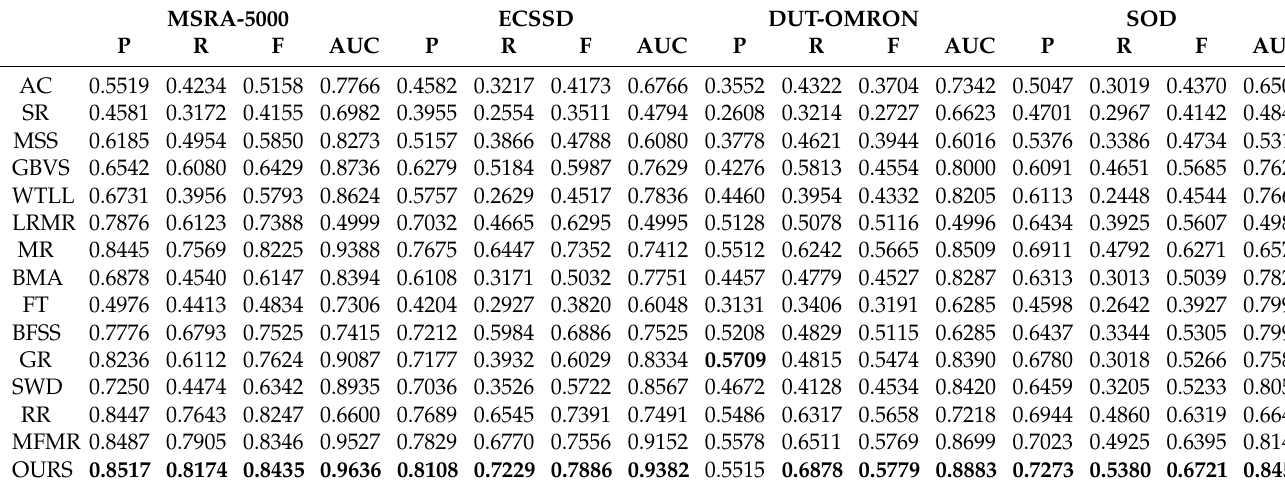
Table 2. Evaluation metrics of different methods in four datasets.